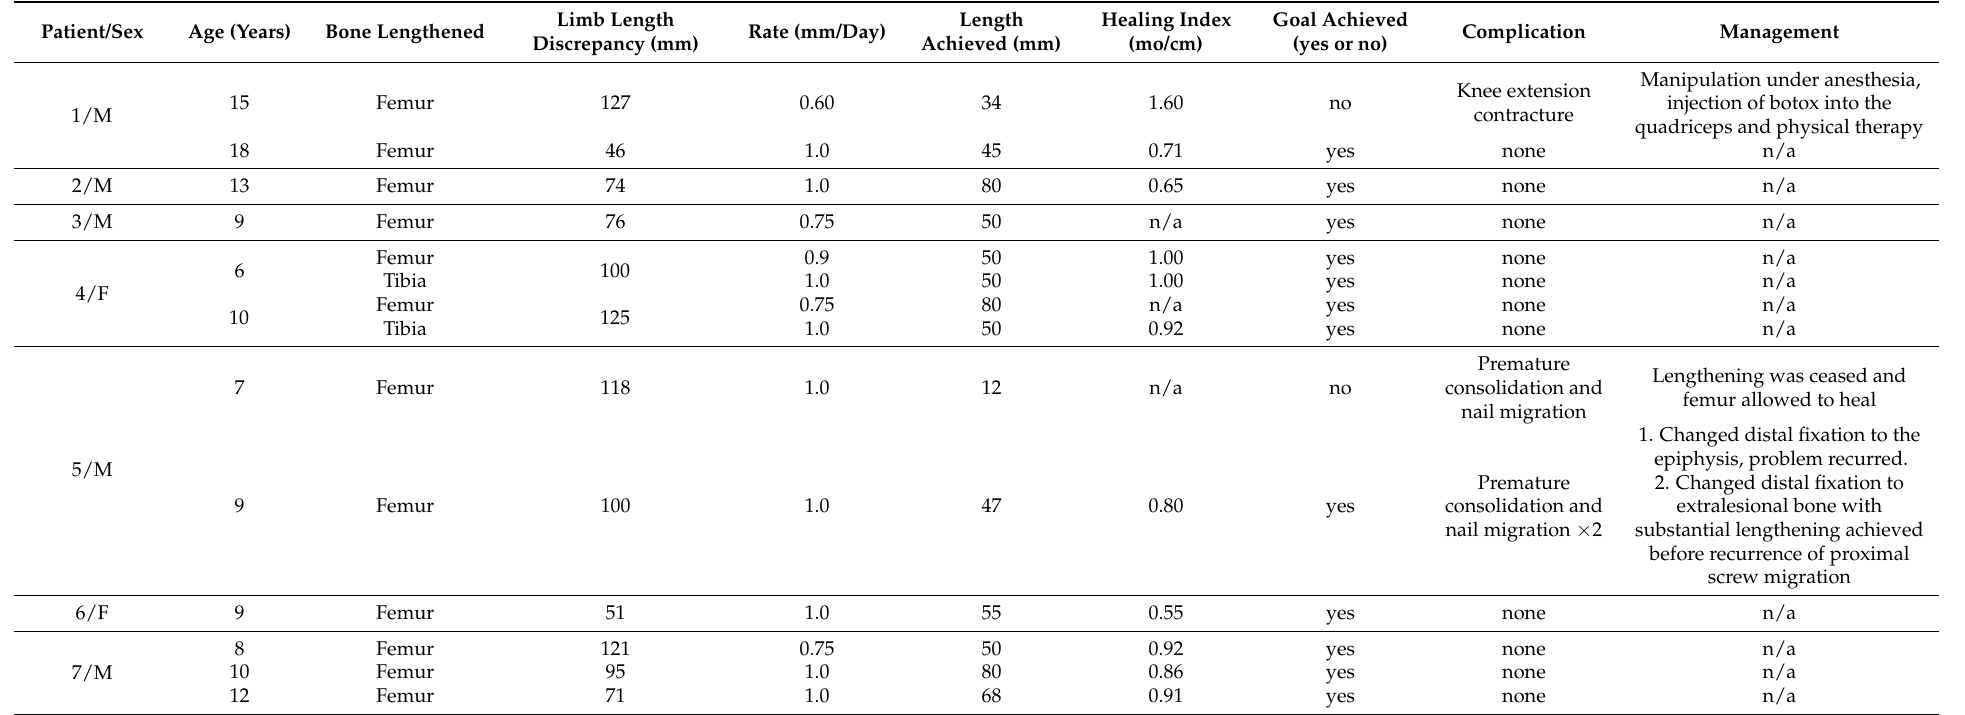
Table 1. Patient summaries. M denotes male and F denotes